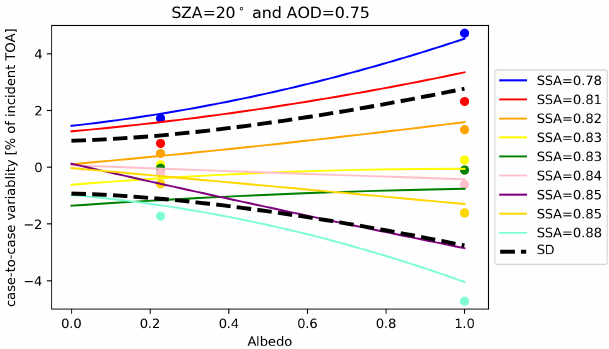
Figure 6. The difference between P DARE and DARE for the indi- vidual cases at a fixed AOD (0.75) and SZA (20 ◦ ). The range of variability is represented by the standard deviation (black dashed curves).